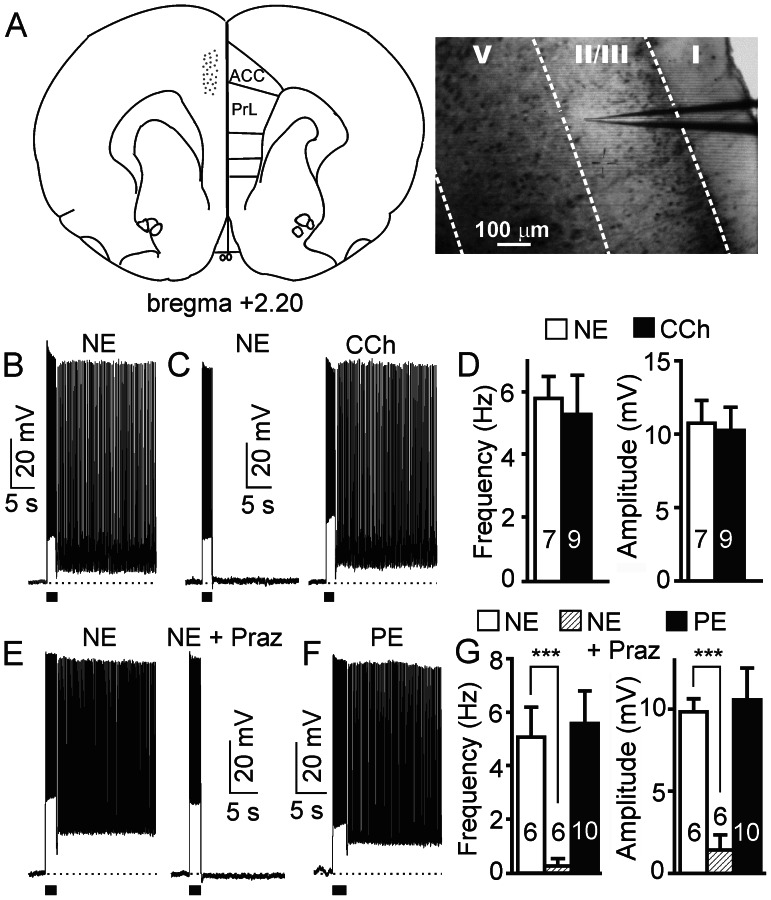
NE induces persistent firing in pyramidal neurons of prefrontal cortex via activation of α1 adrenoceptors.(A) Left: Schematic diagram of a coronal section of rat brain showing the recorded area (dots) in the prefrontal cortex including the rostral anterior cingulate cortex (ACC) and prelimbic cortex (PrL). Adapted from Paxinos and Watson (1998). Right: Typical video image of a brain slice showing the recording site (with a patch electrode) at layer 2/3 of the ACC subdivision of the prefrontal cortex. (B) Sample trace of NE (10 µM)-induced plateau potential and persistent firing following a depolarizing current pulse in a pyramidal neuron. (C) In another group of neurons, NE failed to induce neuronal responses (non-responsive cell, left panel). However, application of carbachol (CCh 10 µM) evoked persistent firing in the same neurons after NE washout (right panel). (D) Quantification of frequency and amplitude of plateau potential of the NE (10 µM, n = 7) and CCh (10 µM, n = 9) effects. (E) NE-evoked persistent firing (NE) is blocked by the selective α1 adrenoceptor antagonist prazosin (2 µM, NE+Praz, n = 6). (F) The selective α1 adrenoceptor agonist phenylephrine (PE, 10 µM, n = 10) also induced NE-like persistent firing in pyramidal neurons of the prefrontal cortex. (G) Quantification of frequency and amplitude of plateau potential of the prazosin and phenylephrine effects shown in E and F. Values are mean ± SEM. *** p<0.001. The dashed line in panel B, C, E and F represents the membrane potential at −60 mV. The short horizontal bar (2 s) underneath the recording trace represents the current pulse stimulation. The description on dashed line and short horizontal bar also applies to Figures 2, 3, 5, 6, 7 and 8.